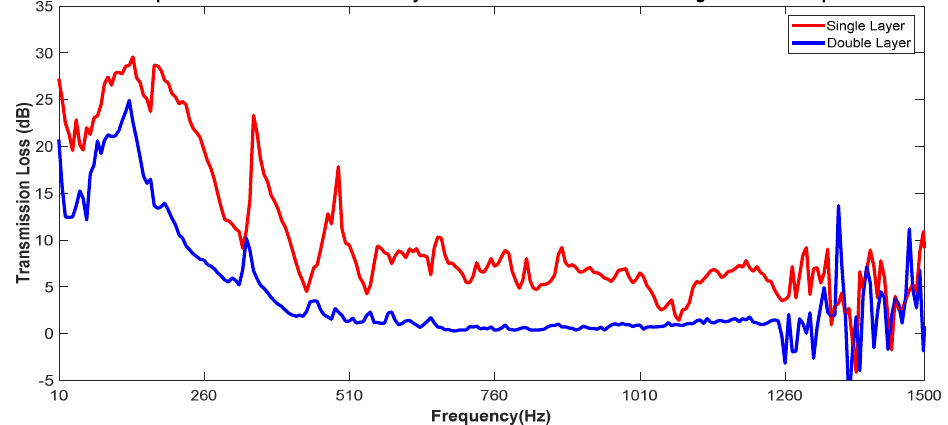
Fig. 4. The acoustic transmission loss versus frequency. The data were collected with air cross-velocity equal to (0m/s) using the perforated